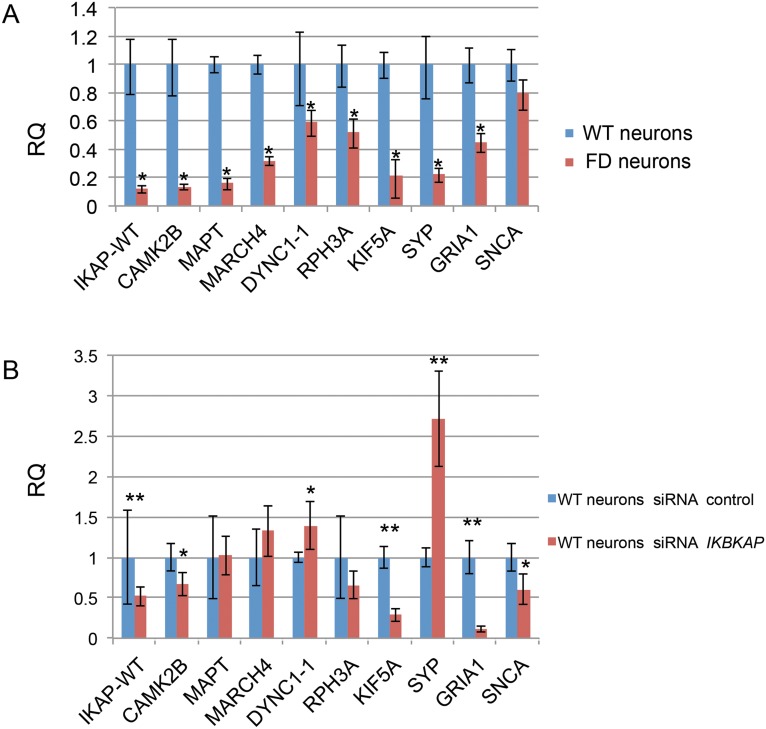
qRT-PCR analysis for validation of IKBKAP predicted co-regulated functional candidate genes in FD neurons and in siRNA IKBKAP downregulated WT neurons.Validation experiments for IKBKAP predicted co-regulated functional candidate genes selected using the “Expander” micro arrays analysis tool were performed by qRT-PCR analysis on cDNA produced from FD hESC derived PNS neurons and on siRNA IKBKAP downregulated WT hESC derived PNS neurons (A) qRT-PCR results of relative quantification levels of IKBKAP and “candidate genes” in WT vs FD hESC derived PNS neurons. (B) qRT-PCR results of relative quantification levels of IKBKAP and “candidate genes” in WT-hESC derived PNS neurons that were treated with control siRNA and siRNA IKBKAP represented as mean ± s.d. * P<0.05 **P<0.01, Non statistical significance (NS).